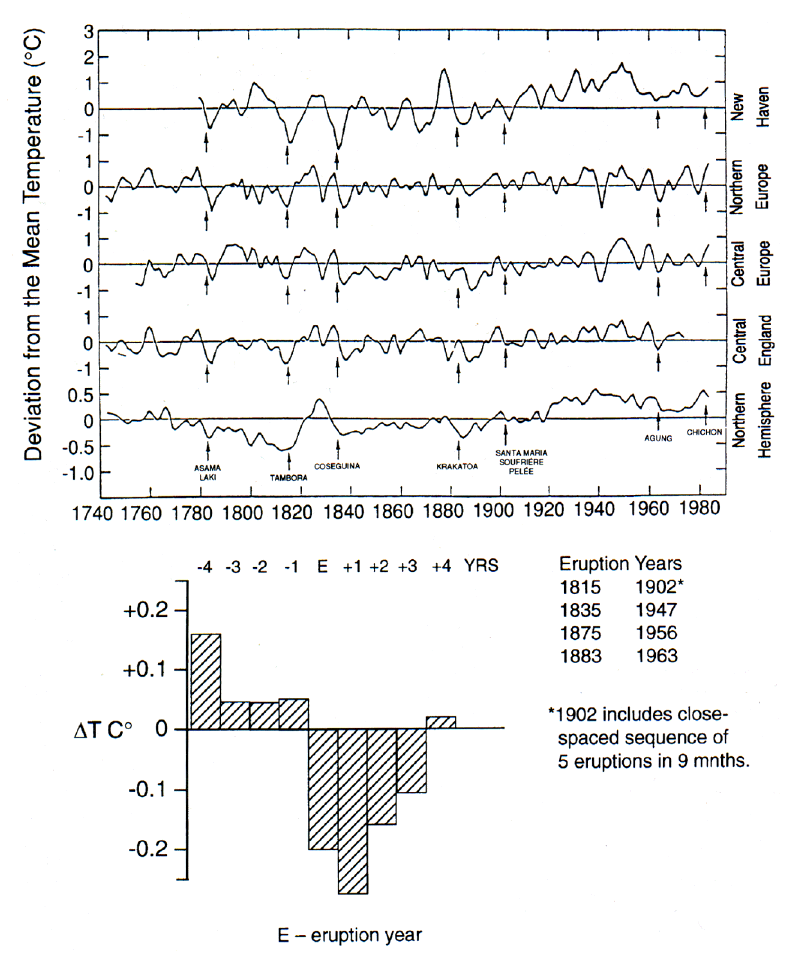
FIGURE 2. Northern hemisphere temperature trends ( ß C) as related to volcanic eruptions over the last 260 years (top). Temperature are smoothed primarily through a 1-2-1 weighting. Any cooling in the years after AD 1783 probably were due to the Laki eruption and not the Asama eruption[64]. Composite of changes in northern hemisphere temperature for the four years before and after major eruptions of the last two centuries (bottom). Reprinted from Quaternary Science Reviews , 19 , Use of paleo-records in determining variability within the volcanism-climate system, 417-438, 2000, with permission from Elsevier Science. Initial permission from American Meteorological Society for top figure and from Elsevier Science for bottom